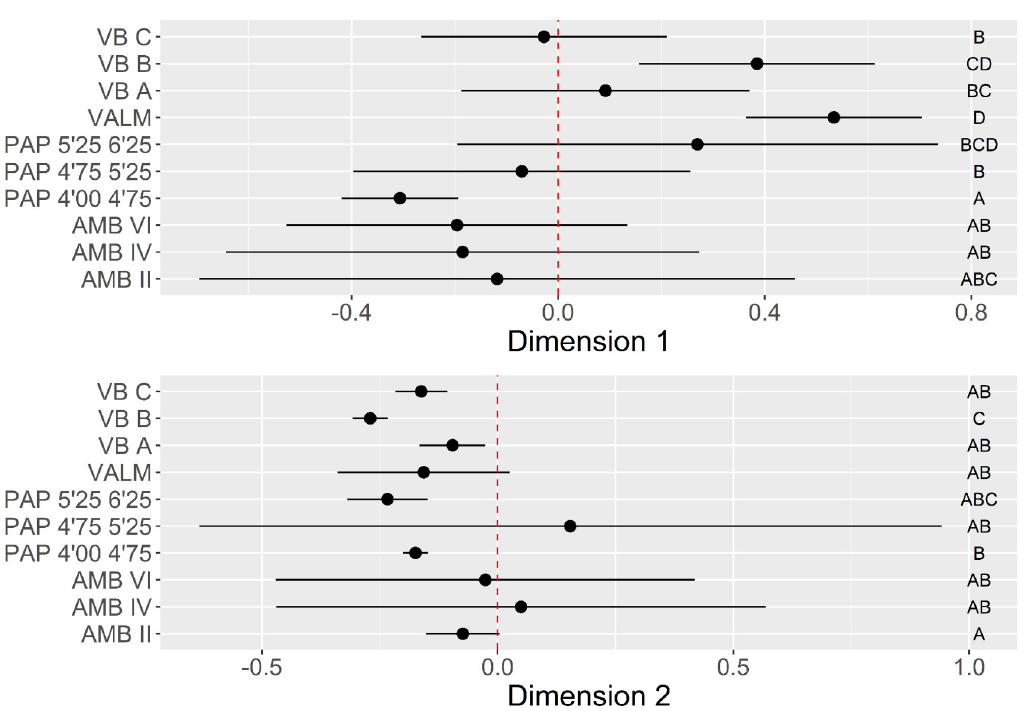
Fig 14. Core morphology multi-comparison bootstrap ANOVA. Error bars represent 95% confidence interval from the mean. Contexts sharing the same set of letters do not present statistically significant difference (p-value � 0.05).